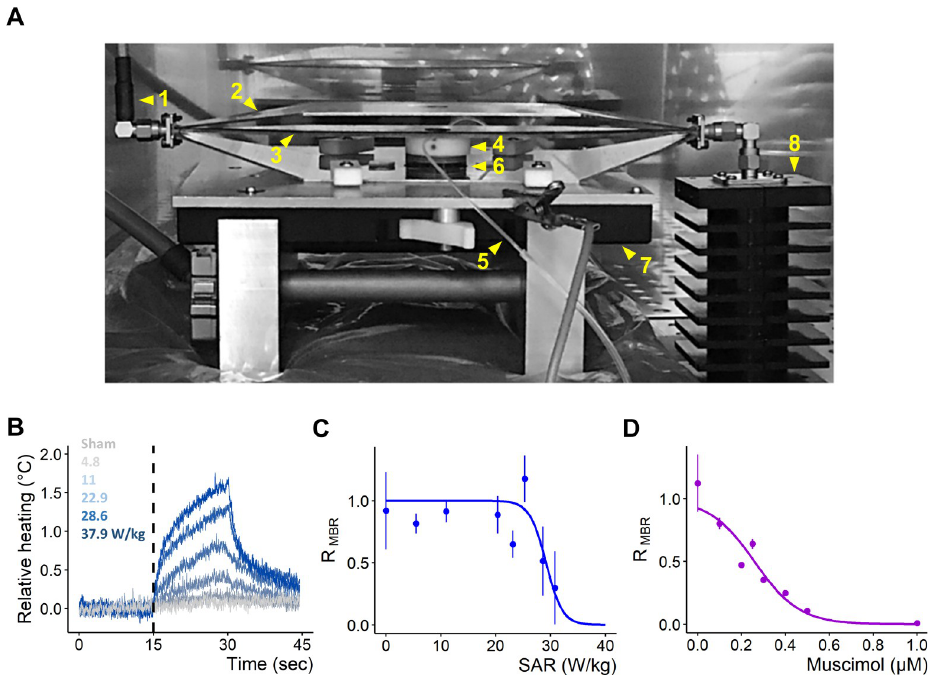
Fig 1. Setup configuration and dose response profile of MBR against SAR level and MU concentration. (A) Photograph of the setup configuration used for simultaneous recording on MEA and exposure to RF fields and pharmacological agents. (1) Coaxial cable connecting an RF-generator/amplifier (located outside the incubator) to (2) an open transverse electromagnetic (TEM) cell. (3) TEM cell septum. (4) Perfusion holder inserted on top of the MEA chamber. (5) Perfusion microtubes for medium exchange. (6) MEA “sandwiched” between TEM bottom ground plate and amplifier ground plate. (7) Inverted MEA preamplifier connected to a MC_Card of a desktop computer. (8) 50 Ω Terminator. (B) Relative heating response of the culture medium over 15 min as a function of different SAR levels (W/ kg). (C) Dose-response relationship between SAR and MBR; results from 21 recordings (18 cultures), 0 (W/kg): n = 21; 5.5: n = 2; 11: n = 3; 20.35: n = 2; 23.1: n = 3; 25.3: n = 3; 28.6: n = 5; 30.6: n = 3. (D) Dose-response relationship between MU concentration and MBR; results from 14 recordings (3 cultures), 1e -4 ( μ M): n = 2; 0.1: n = 3; 0.2: n = 1; 0.25: n = 2; 0.3: n = 1; 0.4: n = 1; 0.5: n = 2; 1: n = 2. (C-D) Normalized MBR, ratio of the exposure phase to baseline, data shown as Median ± SD. Fits computed with non-linear least squares method, Pearson’s Goodness-of-Fit: p <